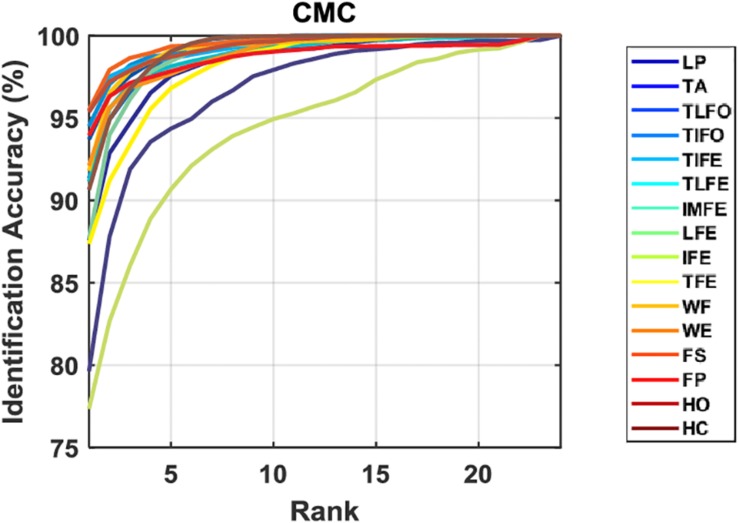
CMC curves for each gesture. The data are averaged across the subjects.